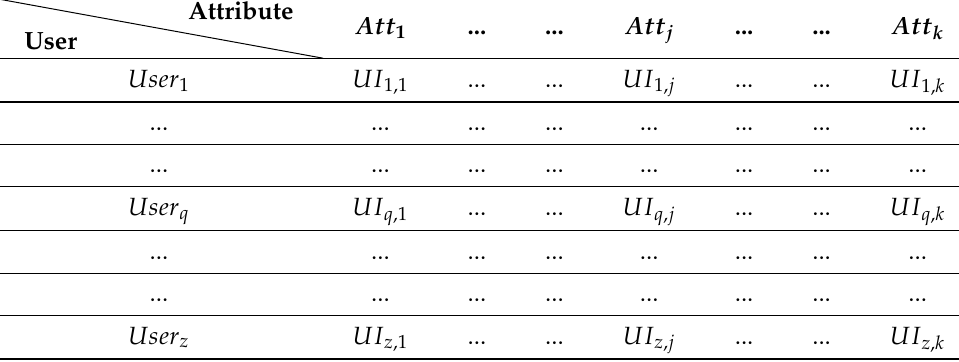
Table 7. User’s interest on items’ categorical